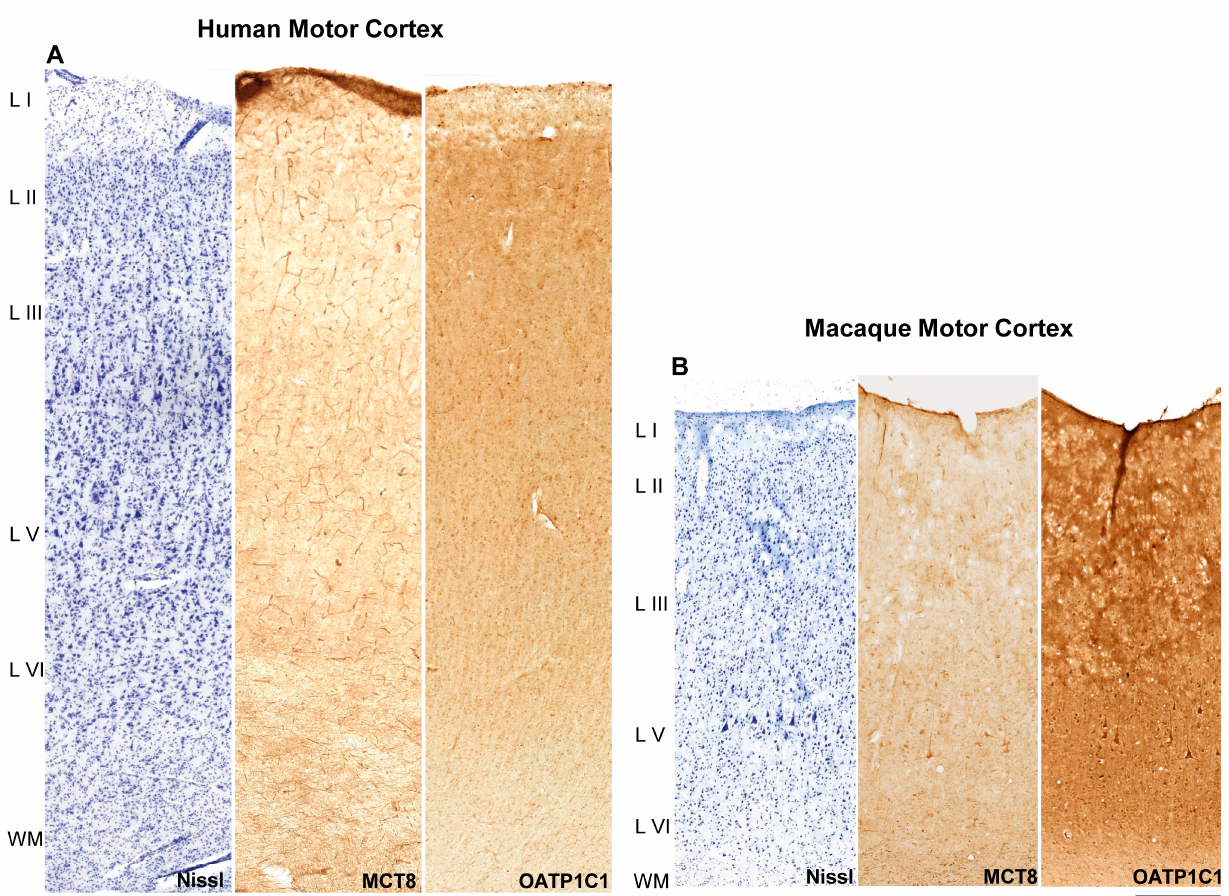
Figure 1. MCT8 and OATP1C1 expression profiles in the motor cortex of humans and macaques. Compositions show representative brightfield photomicrographs taken from adjacent sections of the human ( A ) and macaque ( B ) cerebral motor cortex through layers I to the superficial part of white matter, after Nissl staining (left), immunostaining for MCT8 (middle) and OATP1C1 (right). Note that at this low magnification, large neurons can be observed in layer V of the macaque. MCT8 in humans ( A ) can be observed mainly in blood vessels, while OATP1C1 is observed mainly in cells. In macaque ( B ), however, cells and large vessels express OATP1C1, but not smaller capillaries. L I–VI: layers of the cerebral cortex, WM: white matter. Scale bar = 500 μ m ( A ) and 400 μ m ( B ). 2.2. MCT8 and OATP1C1 Are Expressed in the Vessels of the Human and Macaque